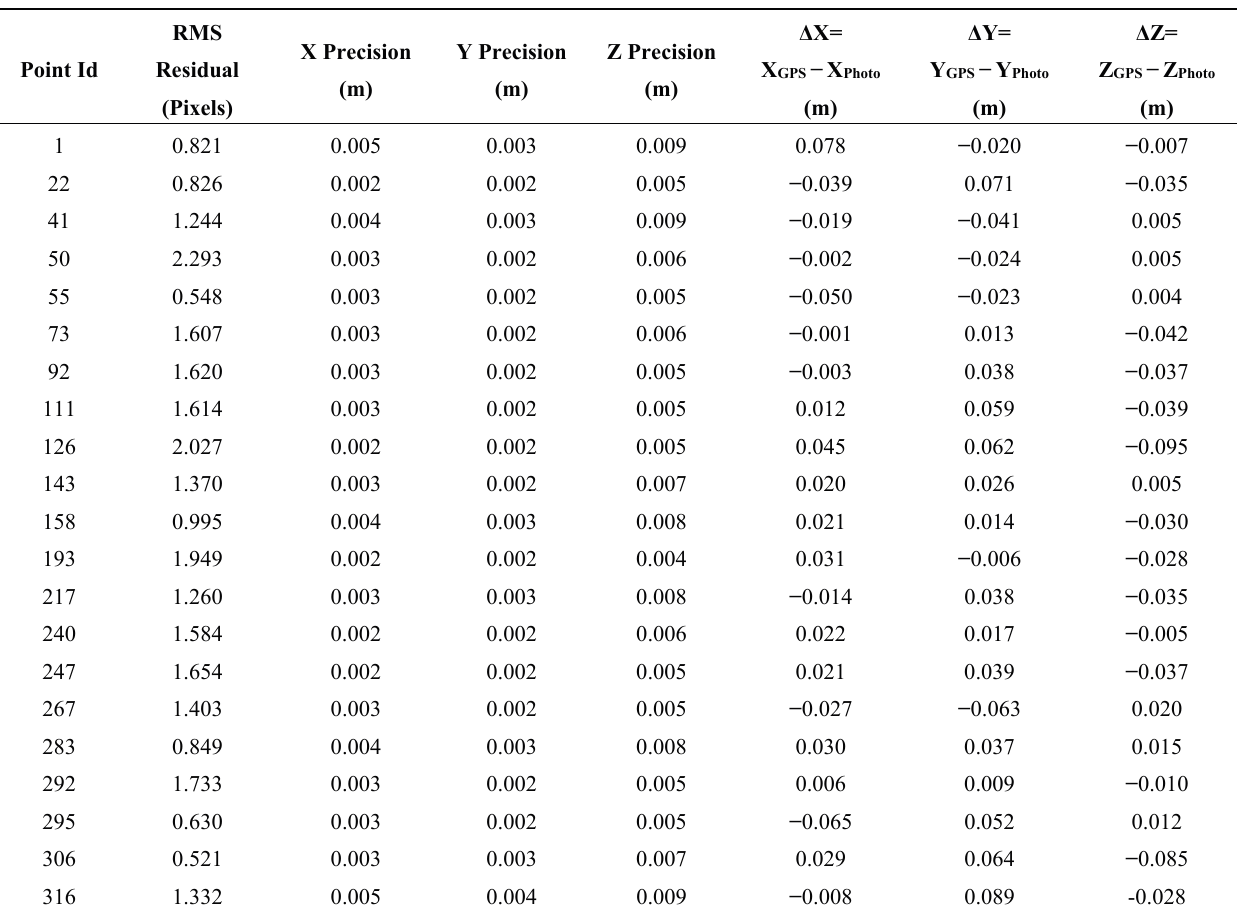
Figure 5. Epipolar lines predict the possible position for a ground control point (GCP) during marking. Table 2. Photogrammetric precisions of GCPs and differences of measurements between GPS and